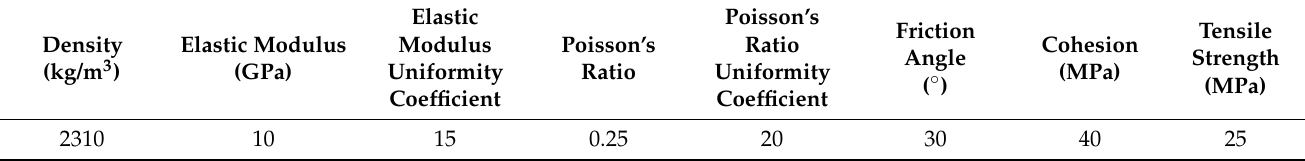
( c ) Figure 9. Rock models after grid generation for three cases: ( a ) Case 1; ( b ) Case 2; ( c ) Case 3. Case 2 uses the optimized DDARF program for grid generation, as shown in Figure 9b, in order to observe the expansion of the preset joint. Dense grids are generated in the area around the preset joint, while in the area away from the preset joint sparse grids are